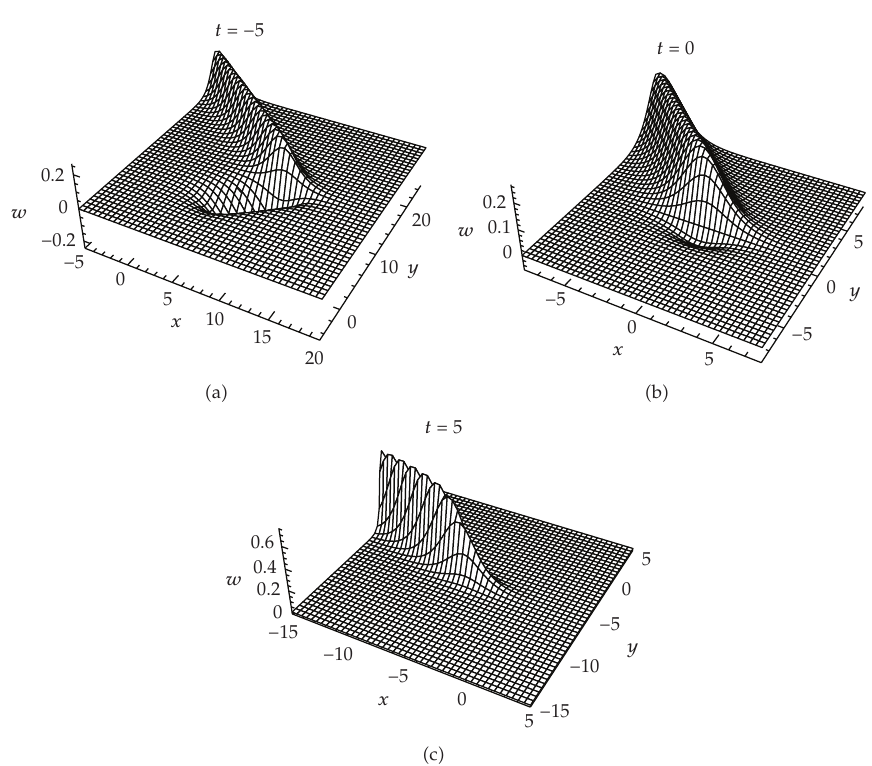
Figure 5: The fussion phenomenon of a dromion-like and a solito ff -like for (cid:2) 4.10 (cid:4) .